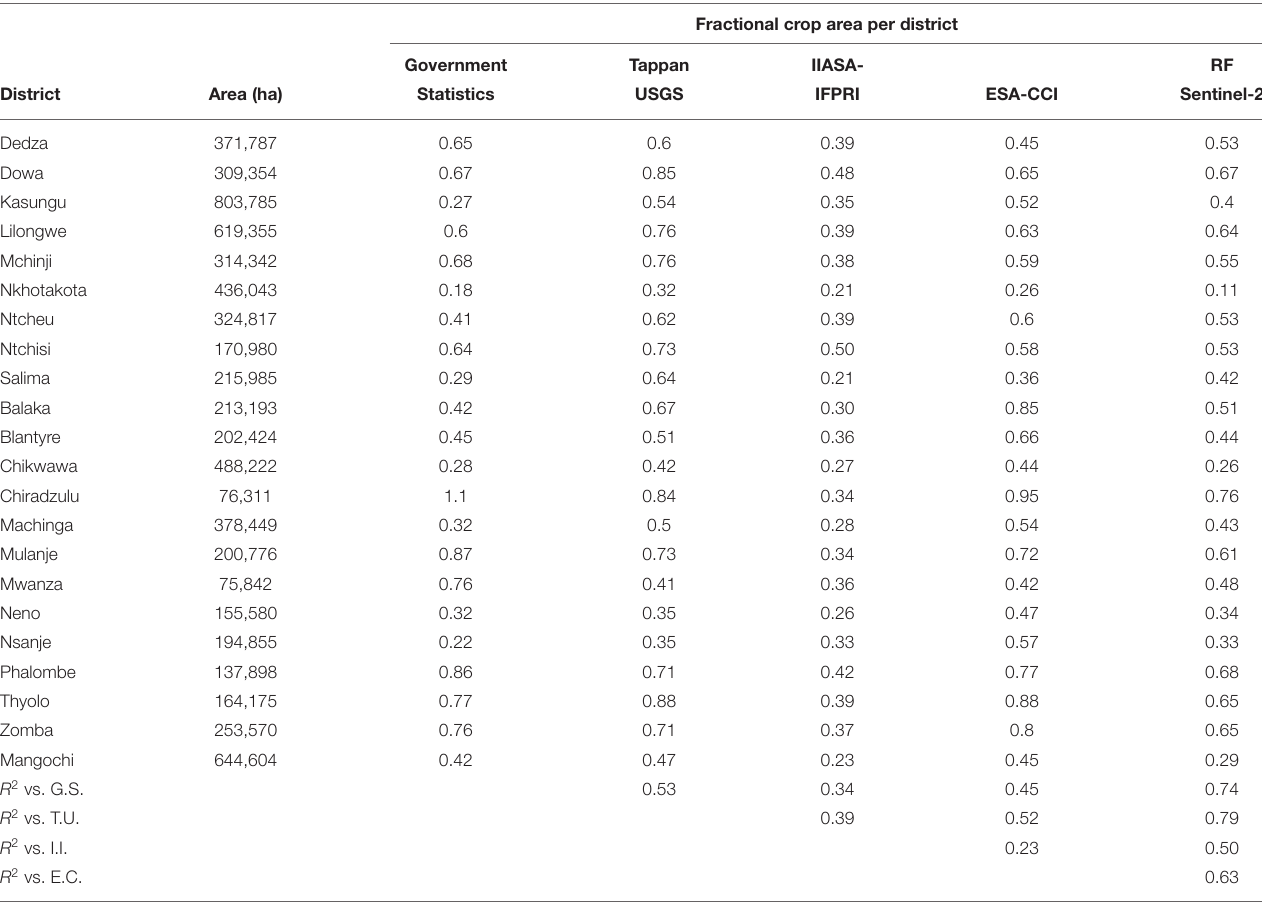
TABLE 6 | Fractional crop area for each district in central (Dedza-Salima) and southern (Balaka-Mangochi) Malawi for the four reference data sets and the Sentinel-2 based analysis. Fractional crop area per district Government Tappan IIASA- RF